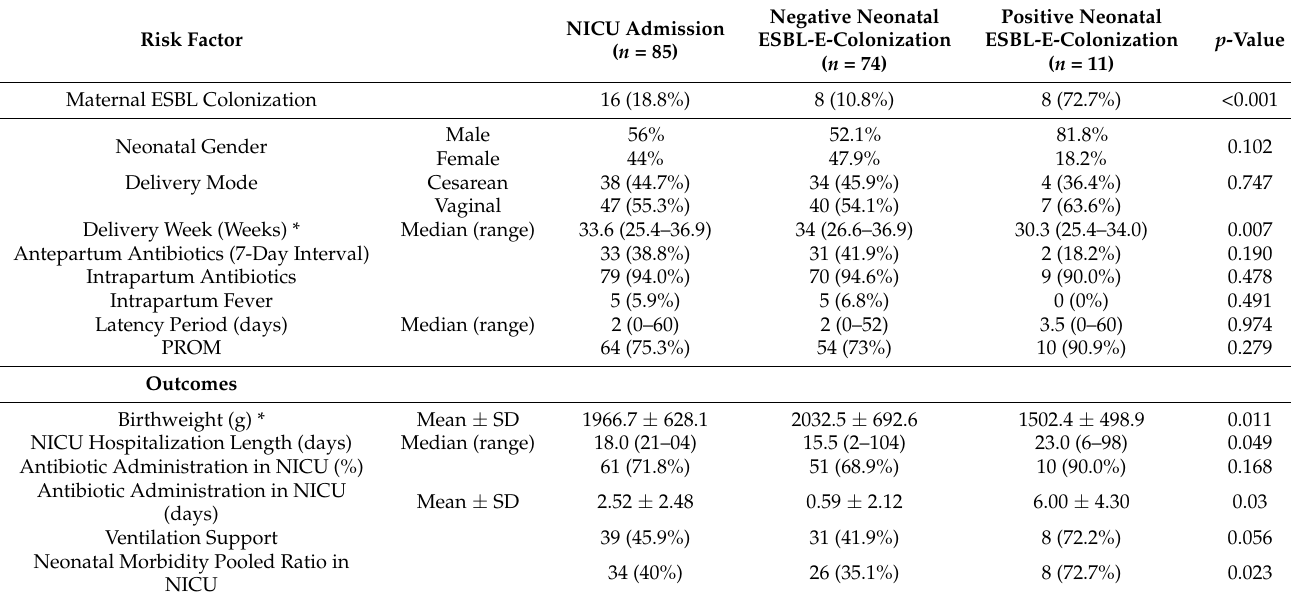
Table 5. Risk factors and outcomes of ESBL-E colonization among neonates in the NICU.